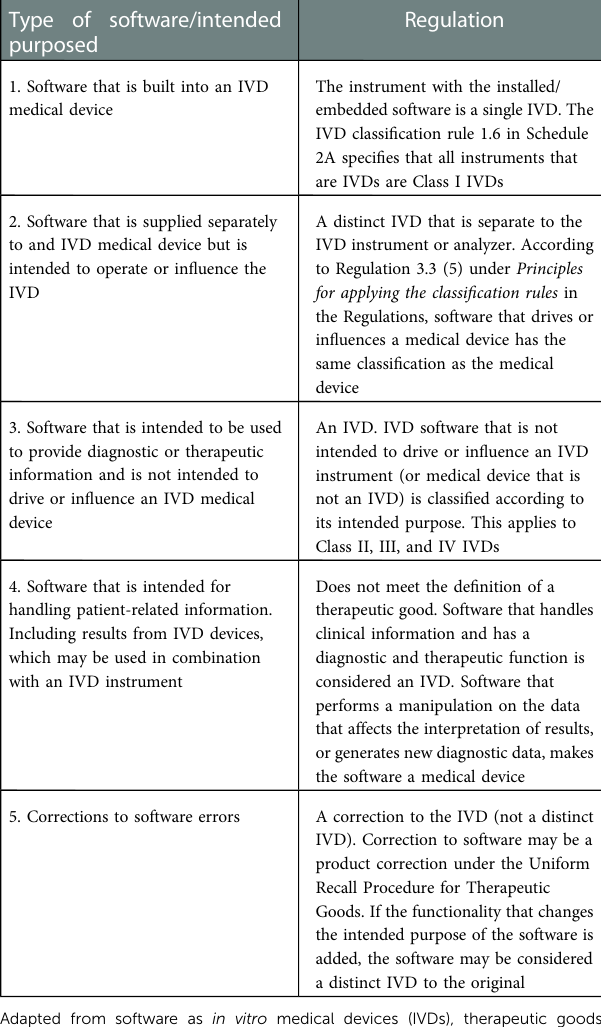
TABLE 5 IVD software regulations in